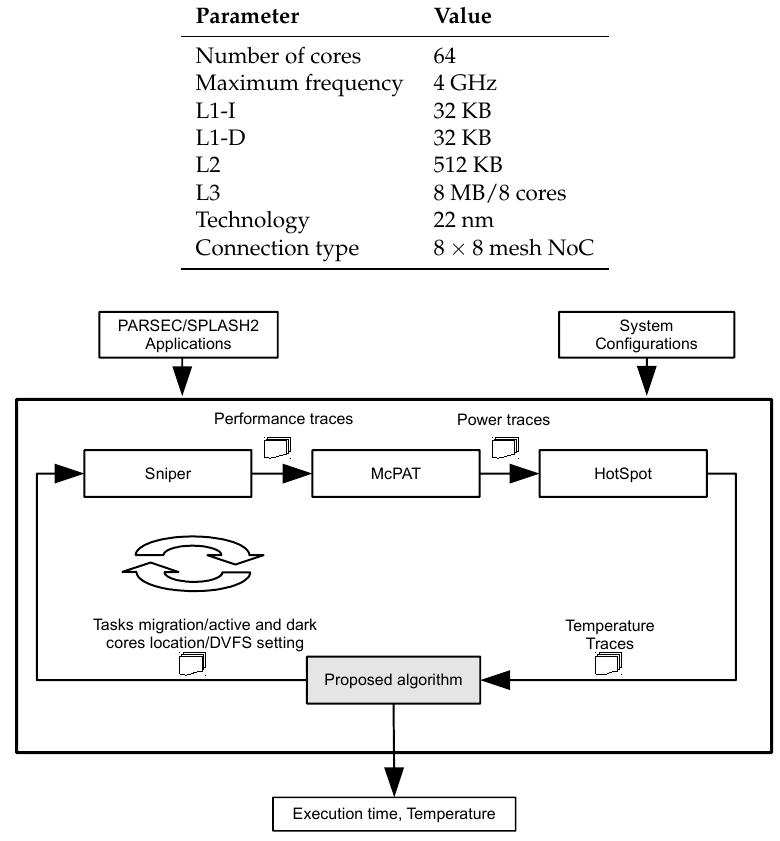
Figure 5. Experimental setup of the proposed